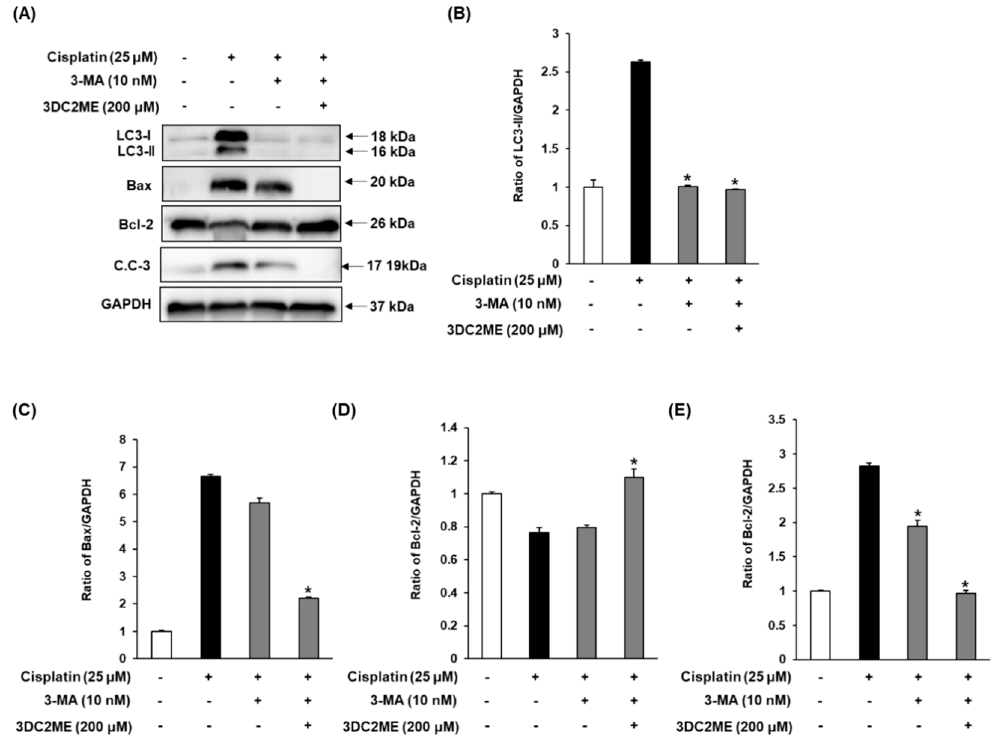
Figure 6. Effect of autophagy inhibitor 3-MA and 3DC2ME isolated from Z. jujuba root extract on expression of ( A ) LC3, Bax, Bcl-2 and cleaved caspase-3 in LLC-PK1 cells treated with 25 µ M cisplatin by western blotting in the presence or absence of 3-MA. ( B – E ) Bar graphs indicated the relative ratio of the western blot band signals in each group as compared with control cells (mean ± SD, * p < 0.05 cisplatin-treated LLC-PK1 cells). 3DC2ME, 3-dehydroxyceanothetric acid 2-methyl ester; 3-MA, 3- methyladenine; SD, standard deviation.